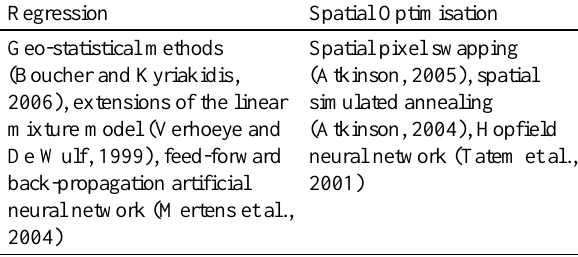
Table 1. Two main categories of SRM techniques (adopted from Atkinson (2008))